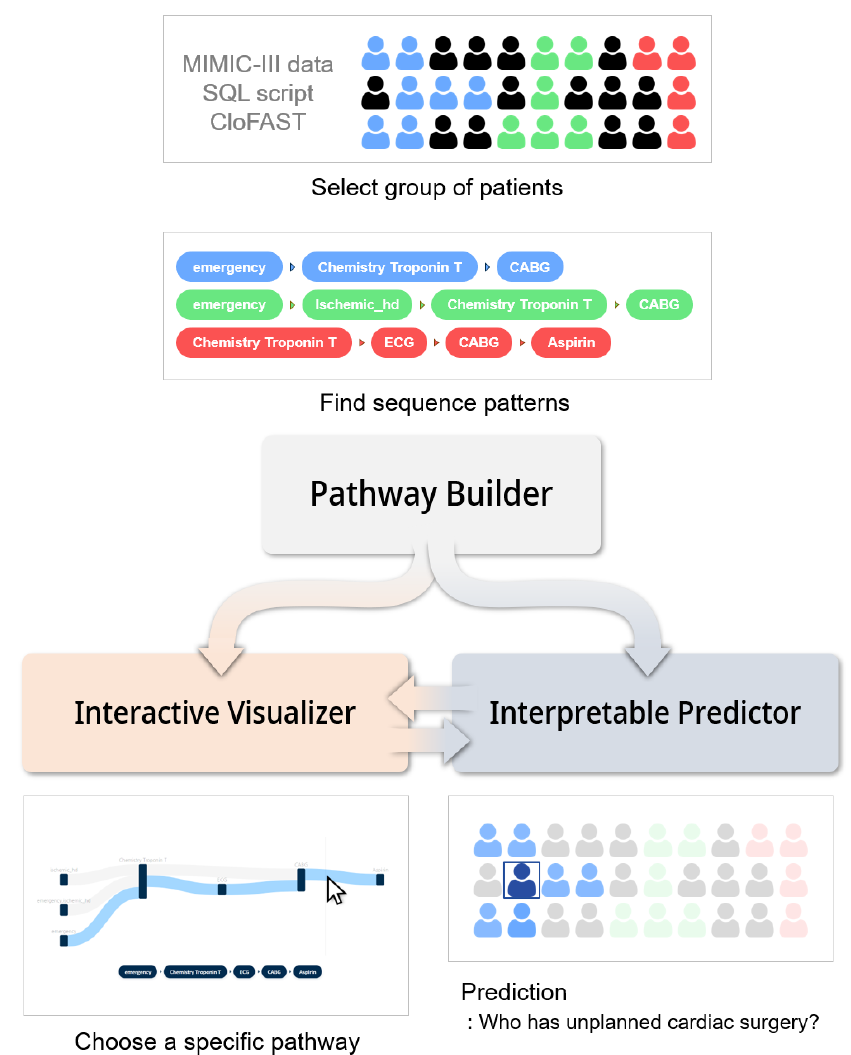
Figure 1. System architecture. CABG, coronary artery bypass